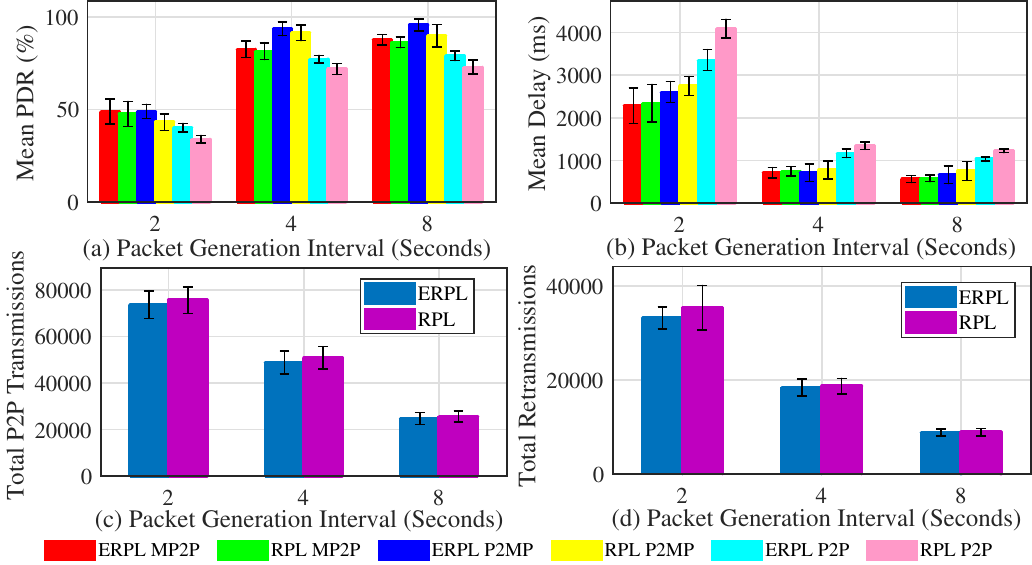
Figure 7. Protocols’ Performances with Different Random Topologies (Gateway at Network